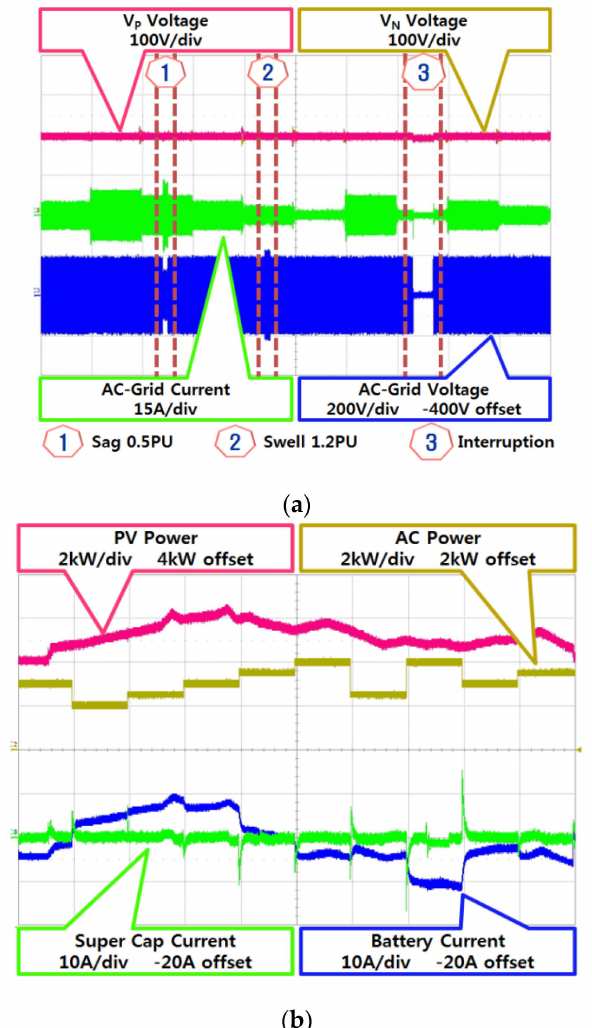
Figure 16. Experimental results for operation analysis: ( a ) DC voltage and AC grid current & voltage, ( b ) PV power, bulk power, SC current, BAT